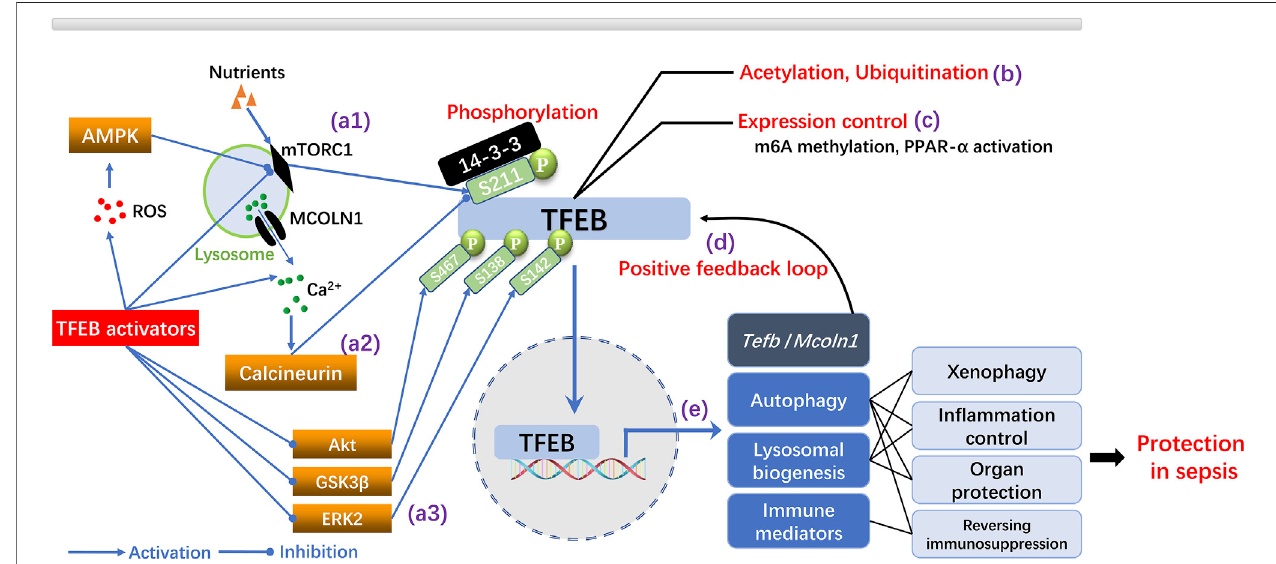
FIGURE1| MechanismsofTFEBactivationandtheprotectiverolesofTFEBdependentALPinsepsis. (A) RegulationofTFEBactivationbyphosphorylation.TFEB is inactivated by mTORC1 dependent phosphorylation at S211 while ROS generation and nutrition deprivation inhibit mTORC1 and suppress TFEB phosphorylation (a1). Lysosomal Ca2+ release through the Mcoln-1 channel activate calcineurin and inhibit TFEB phosphorylation (a2). Inhibition of Akt, GSK3 β or ERK2 dependent phosphorylation of TFEB promotes TFEB activation (a3) (B – C) Modulation of TFEB activation by epigenetic regulation (e.g., acetylation, ubiquitination) or expression control (e.g., m6A methylation, PPAR- α activation). (D) Positive feedback regulation of TFEB by transcriptional upregulation of tfeb and mcoln1 by TFEB. (E) TFEB upregulates autophagy, promotes lysosomal biogenesis and enhance immunity, thereby conferring protection in sepsis.